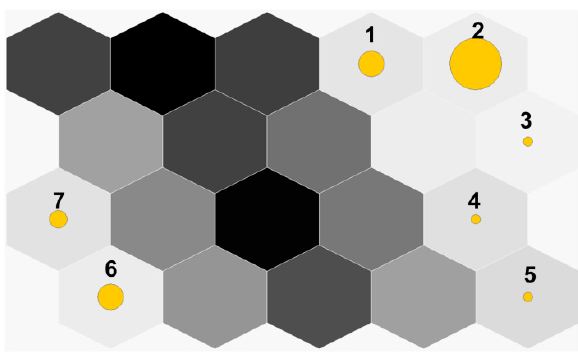
Figure 3. The Employees self-organizing Kohonen map (SOM) view.